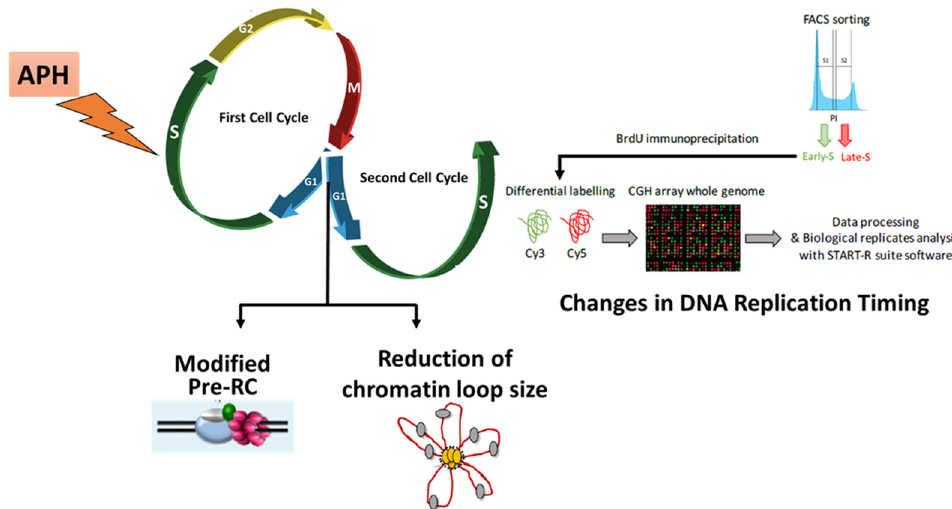
Figure 1. Consequences of RS in the subsequent generation of unstressed cells. Daughter cells showed modified Pre-RC in G1, reduction in chromatin loop size at G1/S transition and changes in DNA replication timing in S phase.